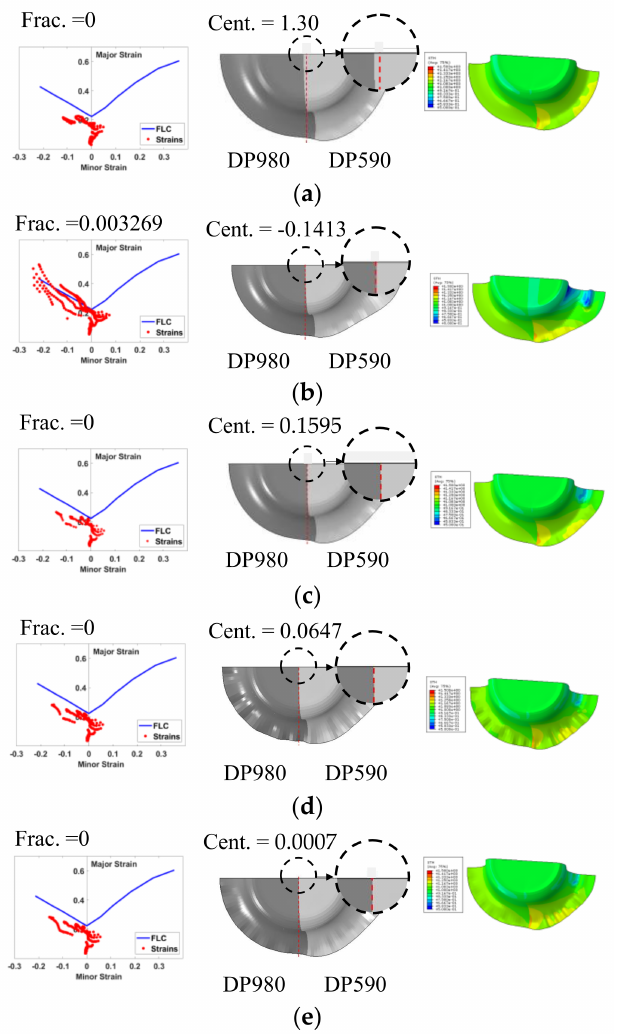
Figure 22. Forming limit diagram, deformed shape, and thickness distribution for five cases: ( a ) no drawbead, ( b ) fixed drawbead, ( c ) adjustable drawbead (optimized with ANN, with initially raised bead), ( d ) adjustable drawbead (optimized with RSM), and ( e ) adjustable drawbead (optimized with